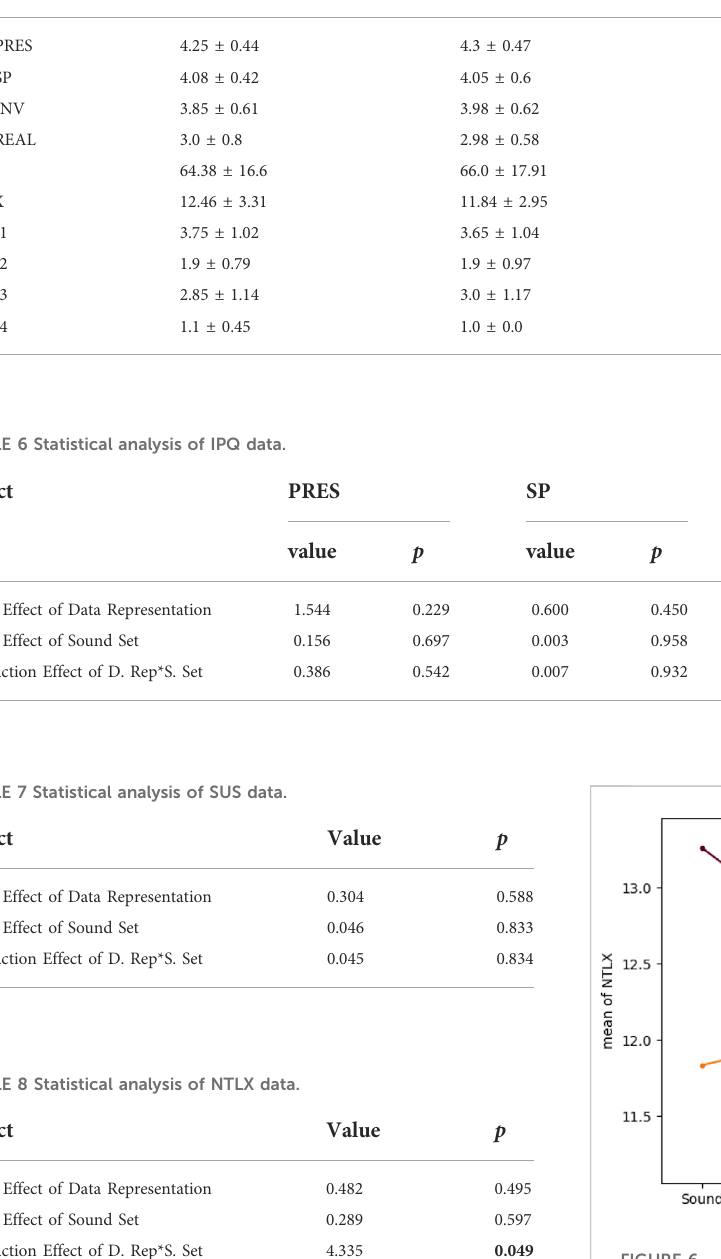
FIGURE 6 Interaction plot of the NTLX